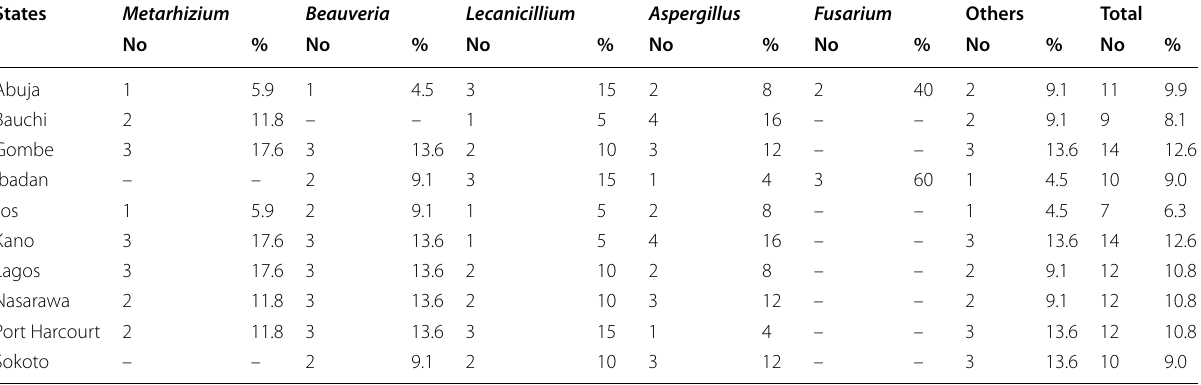
Table 2 Distribution of entomopathogenic , Metarhizium, Beauveria, Aspergillus, Fusarium , and unidentified species from different sampling